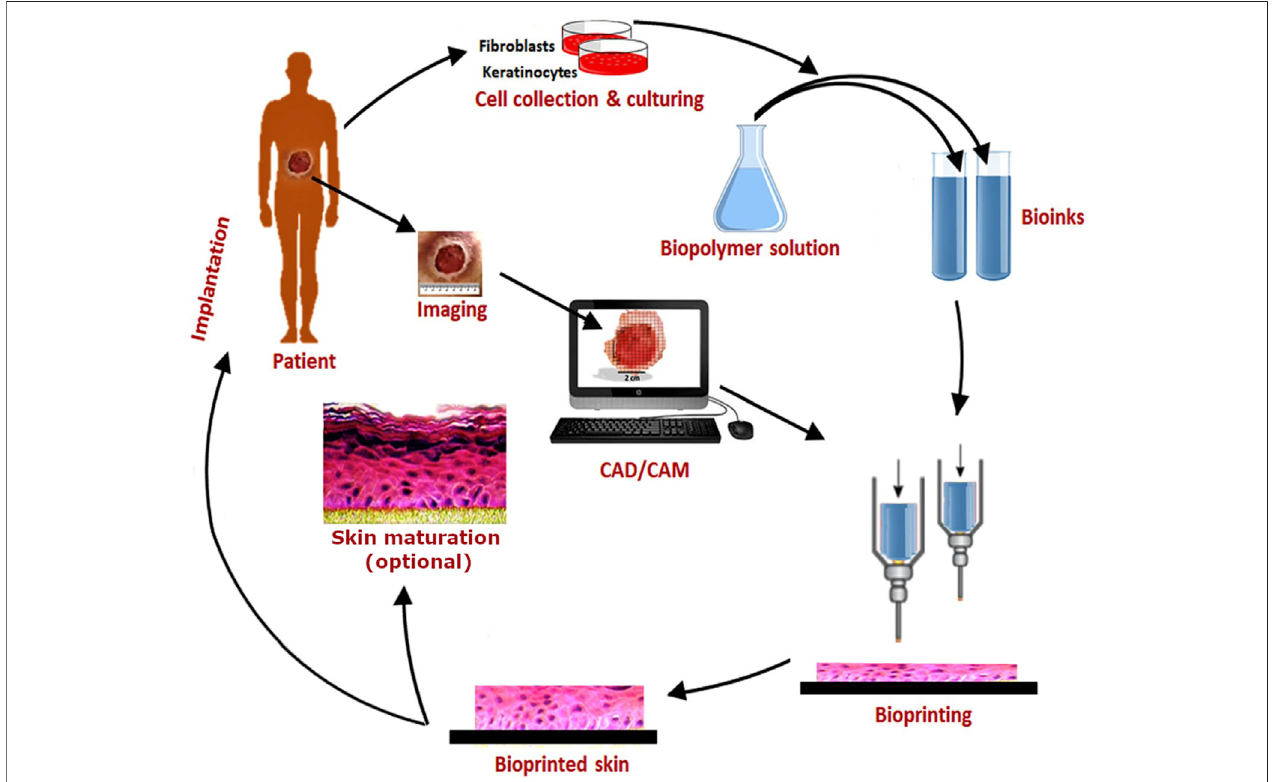
FIGURE 1 | Schematic showing the work fl ow of BP using the example of extrusion BP of skin utilizing two different cell types ( fi broblasts and keratinocytes) and bioinks. Original image taken with permission from Augustine (2018) was adapted.